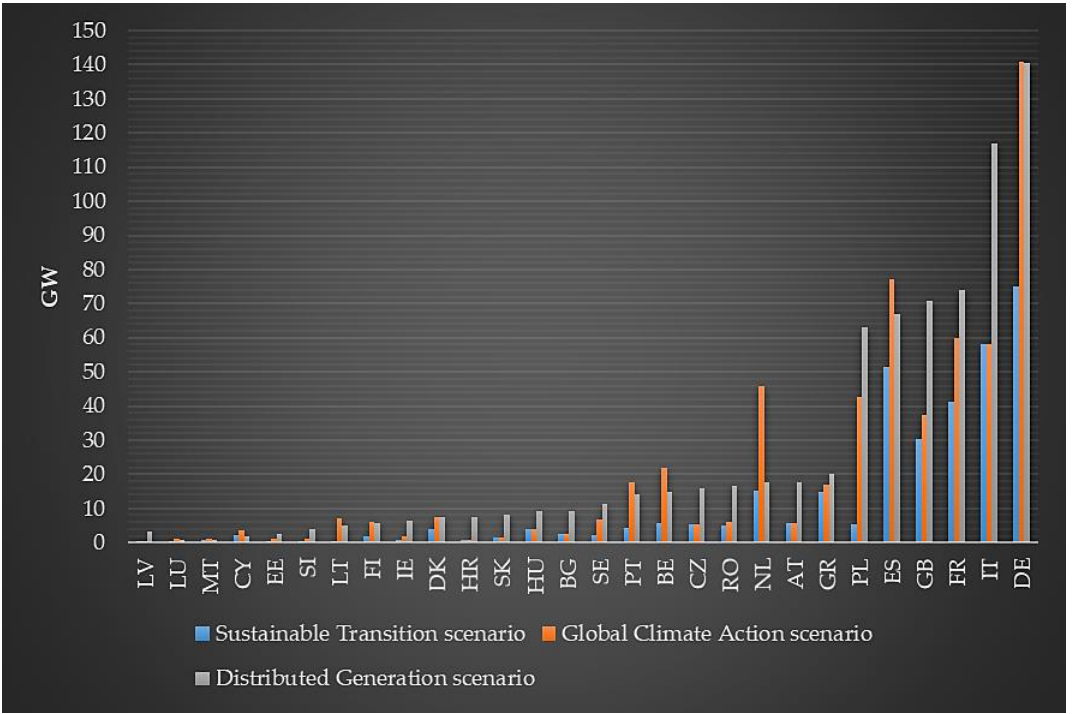
Figure 1. Net photovoltaic (PV) production capacity forecast in the EU based on Entso-E scenarios in 2040 based on [16] .